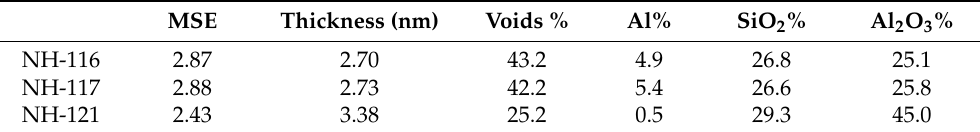
Table 5. Results of the ellipsometry analysis; MSE is the mean square error.